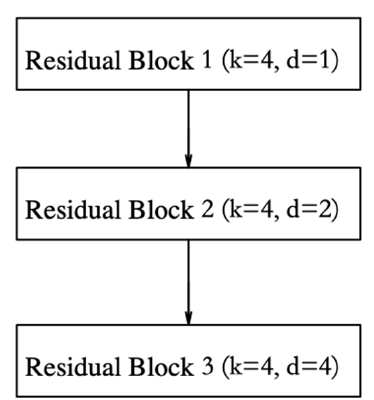
Figure 7. TCN Feature Extractor.